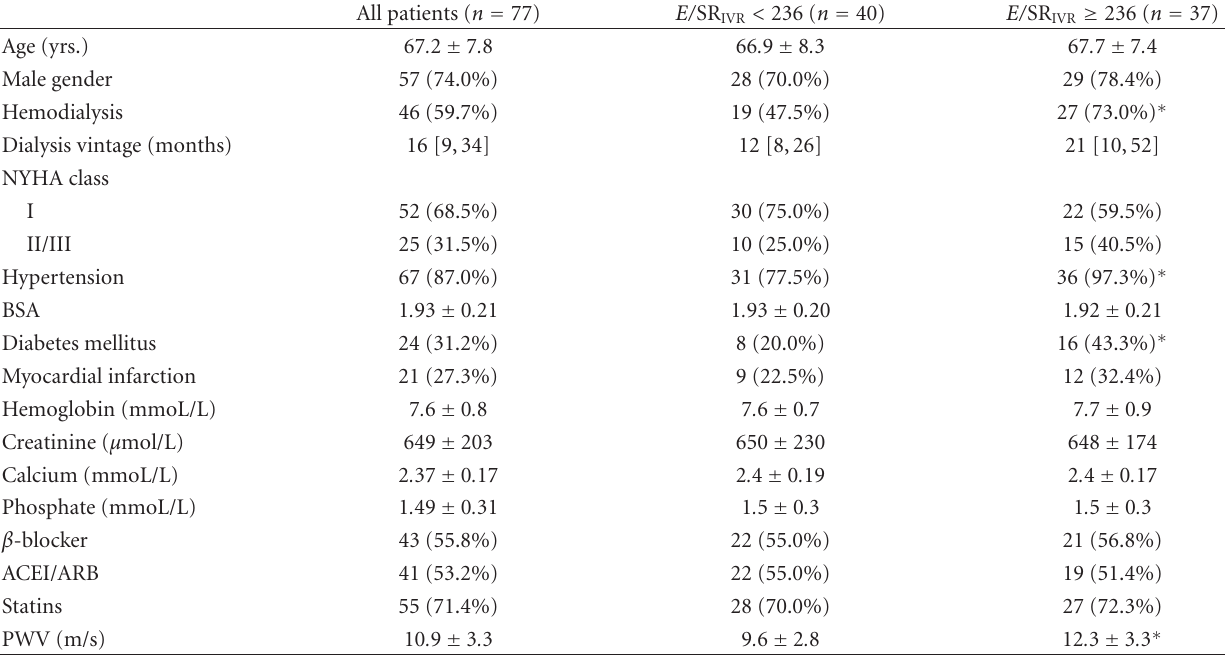
Table 1: Baseline clinical characteristics of the total patient population and divided according to the presence ( E/ SR IVR ≥ 236) or not ( E/ SR IVR < 236) of significant left ventricular diastolic dysfunction.